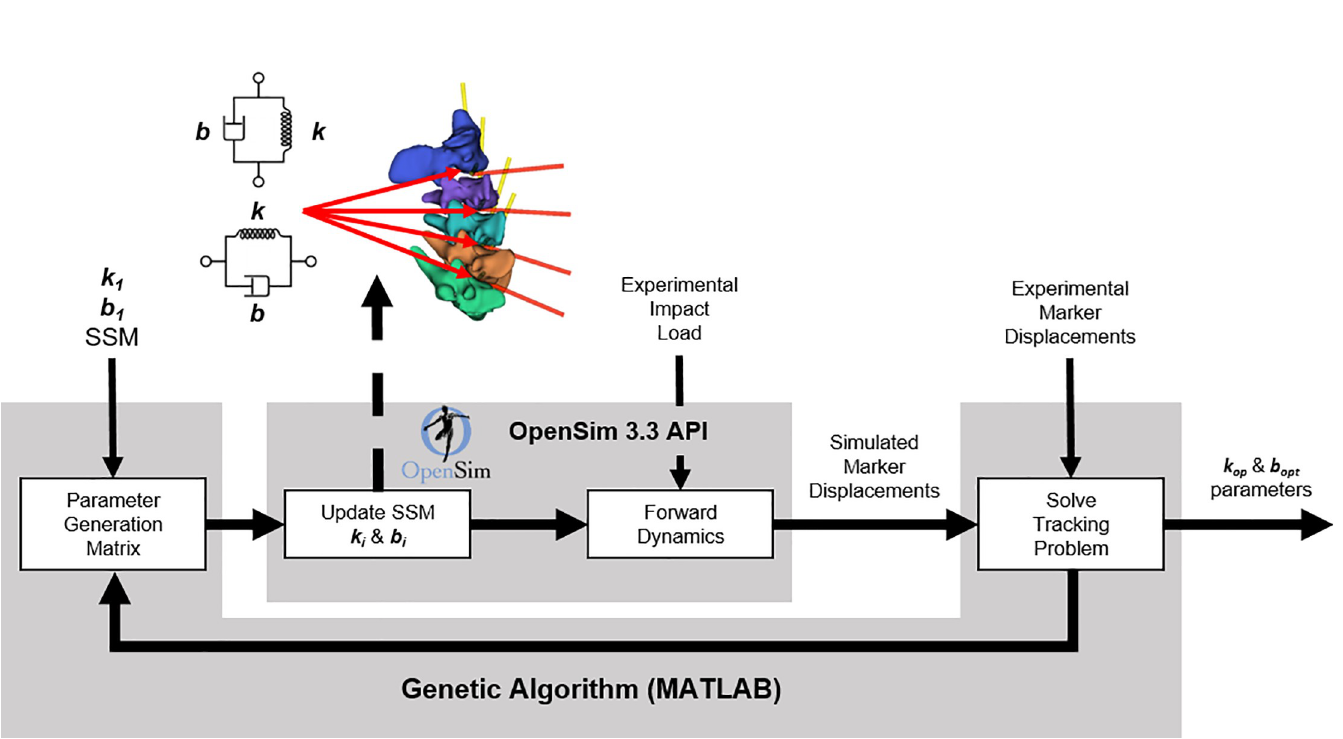
Fig 3. Optimisation pipeline used to estimate specimen specific model viscoelastic joint parameters. Literature values [9] (k 1 and b 1 ) were used to initialise the 6 DoF viscoelastic bushing elements of the specimen-specific models (SSM). A total of 16 optimised stiffness (k opt ) and damping (b opt ) for axial and shear degrees of freedom were